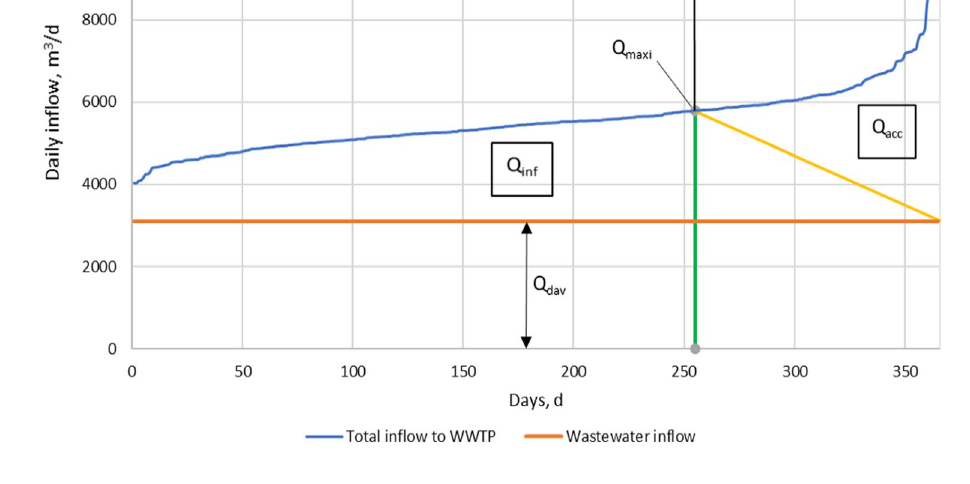
Fig. 3 Volumes of infiltration and accidental water inflow to WWTP in 2015 determined using the triangle